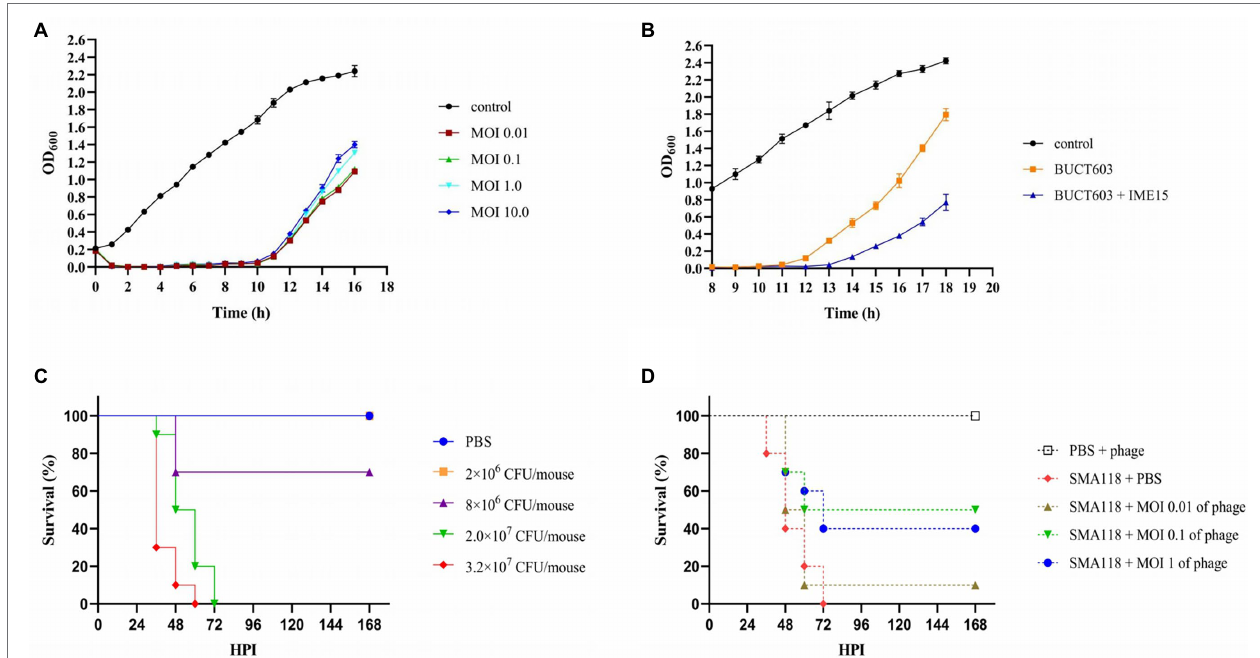
FIGURE 7 | The inhibitory effect of phage BUCT603 on SMA118 in vitro and in vivo . (A) Growth curves of SMA118 infected with BUCT603 at different MOIs; (B) BUCT603 and IME15 were combined in a 1:1 ratio at MOI 0.1 to infect SMA118; (C) Survival curves of mice after inoculation with different concentrations of SMA118; (D) Survival curves of mice inoculated with SMA118 or PBS and treated with phages with different